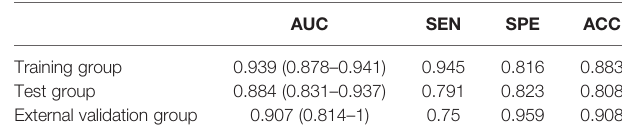
TABLE 3 | Evaluation of radiomics